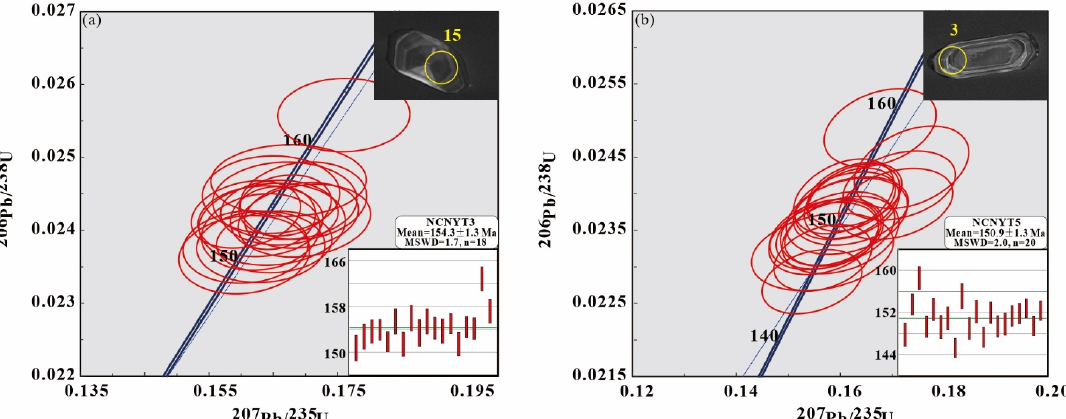
Figure 4. LA-ICP-MS U-Pb concordia diagrams and weighted mean ages for the Nuocang granodiorite samples NCNYT3 ( a ) and NCNYT5 ( b ). The insets show typical CL images of zircon grains with 238 U/ 206 Pb ages. The white scale bar in the CL images is 100 μ m. Hf isotopic analyses were conducted on a Neptune Plus MC-ICP-MS in combination with a Geolas HD excimer ArF laser ablation system in the Wuhan Sample Solution Ana- lytical Technology Co., Ltd. The 179 Hf/ 177 Hf and 173 Yb/ 171 Yb ratios normalized to 0.7325 and 1.132685 [39] in order to calculate the mass bias of Hf ( β Hf ) and Yb ( β Yb ). 176 Lu/ 175 Lu =